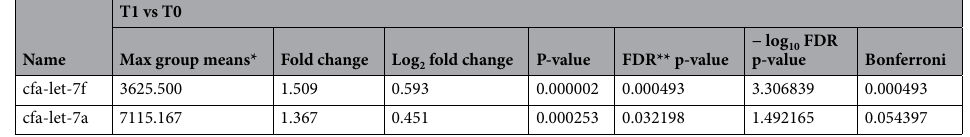
Table 2. EcmiRNAs NGS data. Data were filtered with max group means higher than 10, an FDR-p-value less than 0.05, and a standard p-value (significance at < 0.05). Differential expression analysis of serum miRNome at T1 vs T0 revealed that cfa-let-7f (FDR p-value < 0.001 applying Bonferroni correction for multiple tests 0.000493) and cfa-let-7 (FDR p-value < 0.05 applying Bonferroni correction for multiple tests 0.054397) were significantly upregulated. *Max group means is the maximum of the average RPKM’s (Reads Per Kilobase of transcript, per Million mapped reads). **False discovery rate corrected p-value is the expected proportion of false-positive genes in a set of genes.